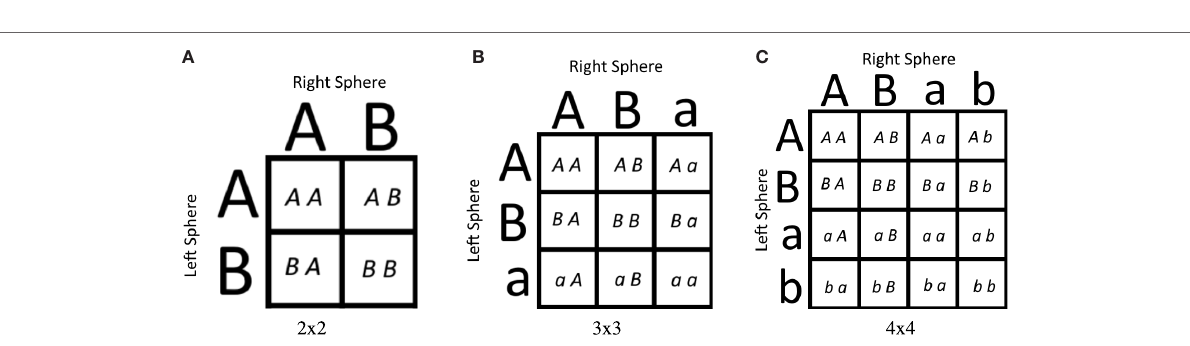
Fr ontiers in Robotics and AI |